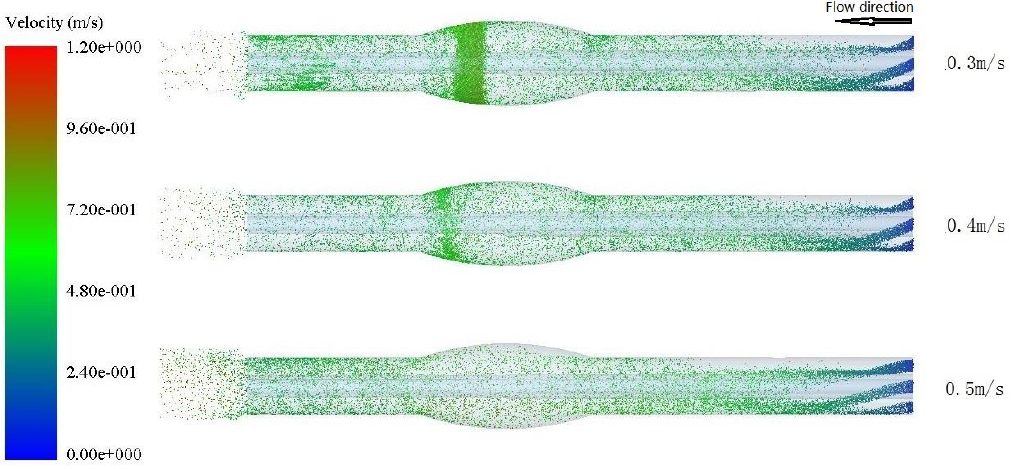
Figure 5. Particle distribution map after 10 s simulation time with di ff erent velocity under 45-degree angle expansion.